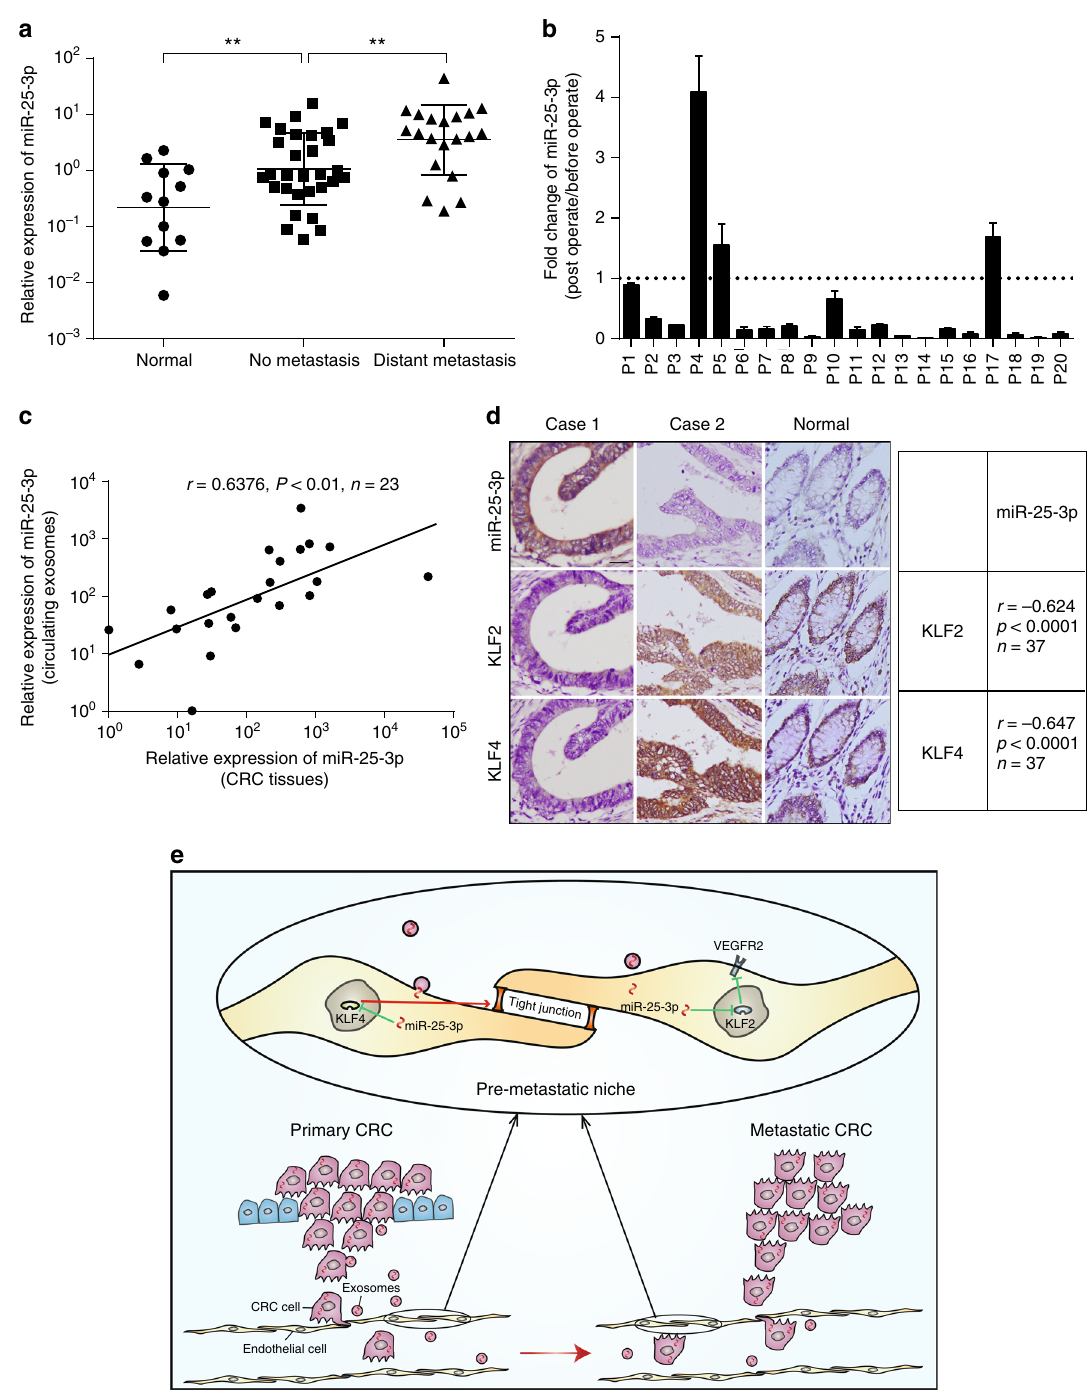
Fig. 7 Serum exosomal miR-25-3p is associated with CRC metastasis. a RT-PCR analysis of miR-25-3p level in circulating exosomes from healthy donor or CRC patients (12 cases of healthy donors, 36 cases of patients without metastasis, 15 cases of patients with metastasis). ** P < 0.01 according to two-tailed Student ’ s t test. b Fold change of miR-25-3p in circulating exosomes from 20 CRC patients after surgical resection of CRC tissues. The expression of miR- 25-3p in circulating exosomes from CRC patients at post-operation stage was normalized to 1. c Spearman correlation analysis between miR-25-3p levels in CRC tissues and miR-25-3p levels in circulating exosomes from CRC patients. Pearson ’ s correlation coef fi cient (r) and P- value are shown, n = 23. P -value is from Spearman ’ s test. d Spearman correlation analysis between miR-25-3p expression and KLF2, KLF4 expression in CRC tissues. Pearson ’ s correlation coef fi cient (r) and P- value are shown. P- value is from Spearman ’ s test. Scale bar represents 50 µ m. e Schematic diagram of the role of CRC-secreted miR- 25-3p in pre-metastatic niche